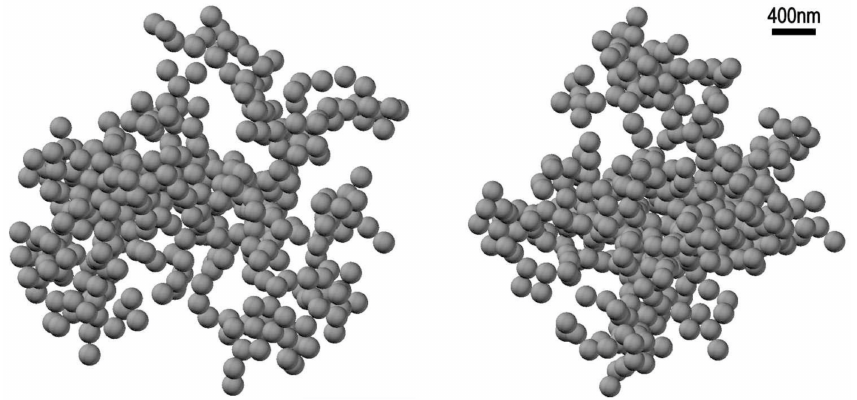
Figure 9. Mutually perpendicular projections of a stochastic realization of hierarchic bubston cluster with the parameters: the number of bubstons N = 400, the bubston radius R = 100 nm, fractal dimension D = 2.45, see